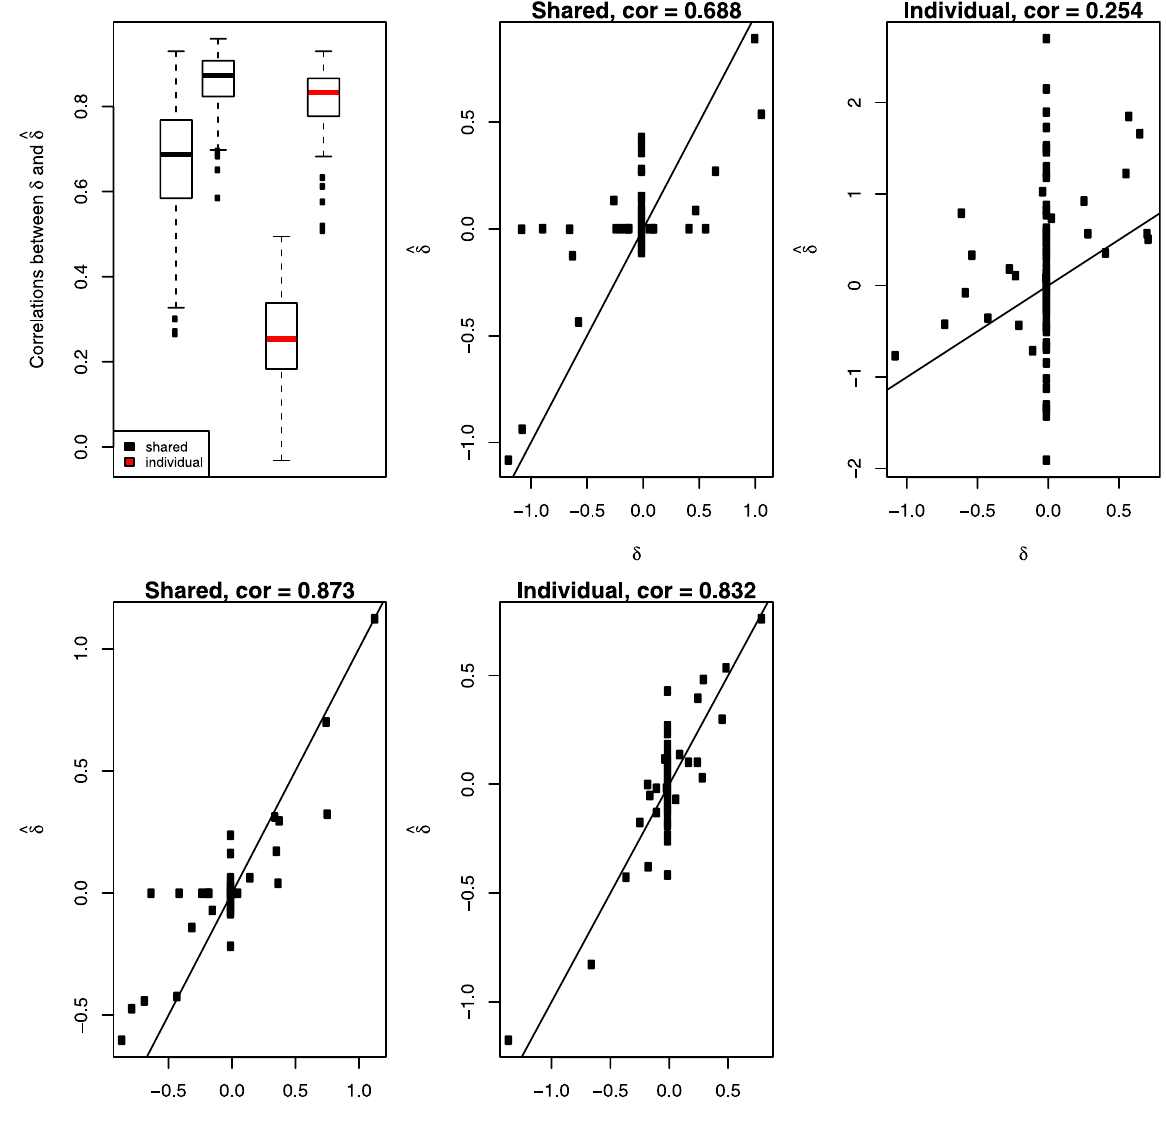
Figure 3. Top left panel: Simulation correlations between estimated δ and the true δ across the 200 runs of the simulation for the shared model (black) and extracted from fitted individual models (red). The side by side boxplots represents the two different sample sizes in the simulation. All other panels show the scatterplots of estimated values of δ versus true values at the median correlations from the boxplots in the top left